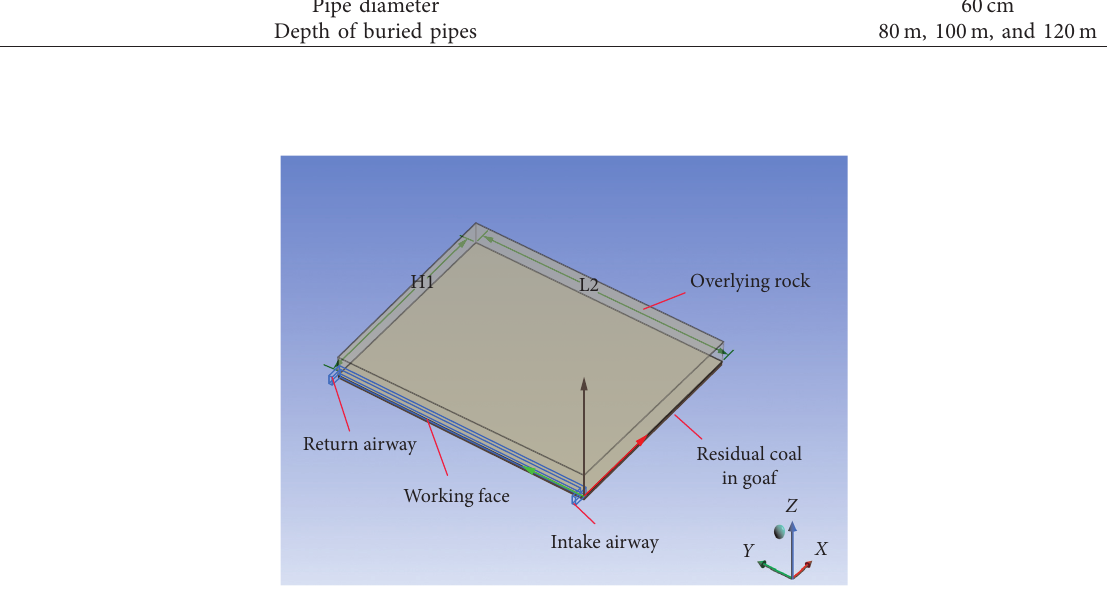
Figure 13: Geometric description of the model.